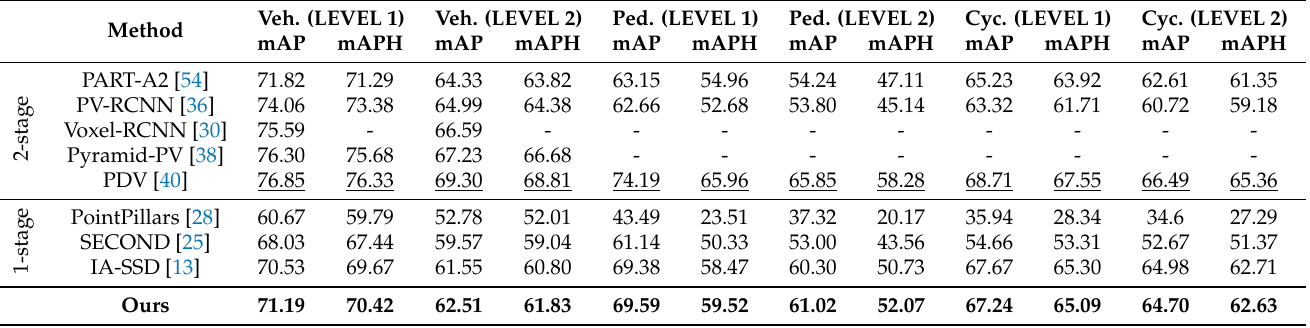
Table 3. Quantitative detection performance achieved on the Waymo validation set. The results of our SGSSD are shown in bold, and the best results are